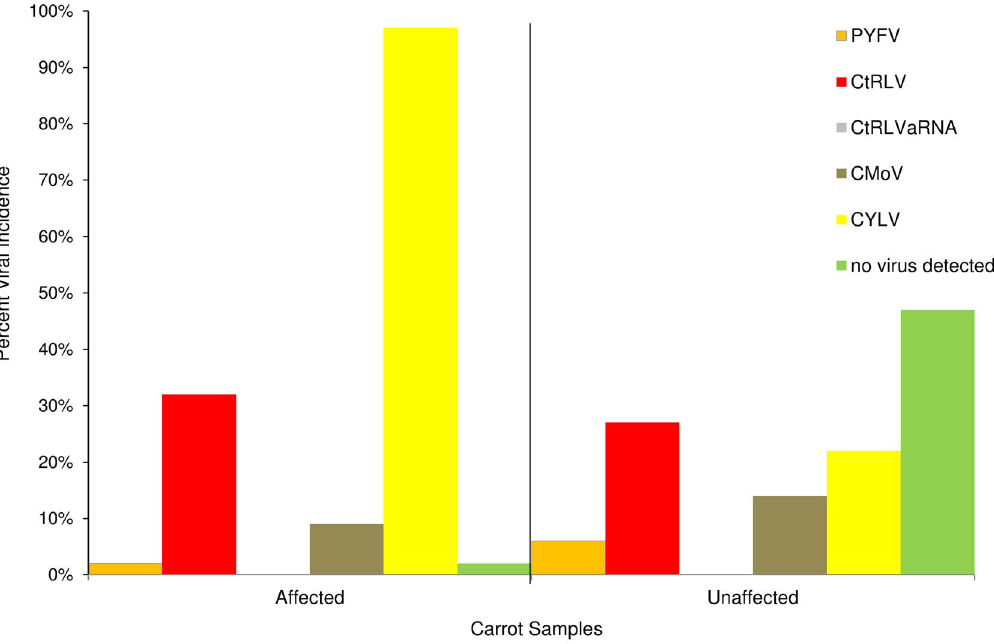
Figure 2. Percent virus incidence in carrot roots from the total field sample of 102 affected and 99 unaffected carrots for the presence of viruses including CYLV, presented as a percentage of carrots with necrosis symptoms (affected) and without necrosis symptoms (unaffected) where virus was detected by PCR or TaqMan.